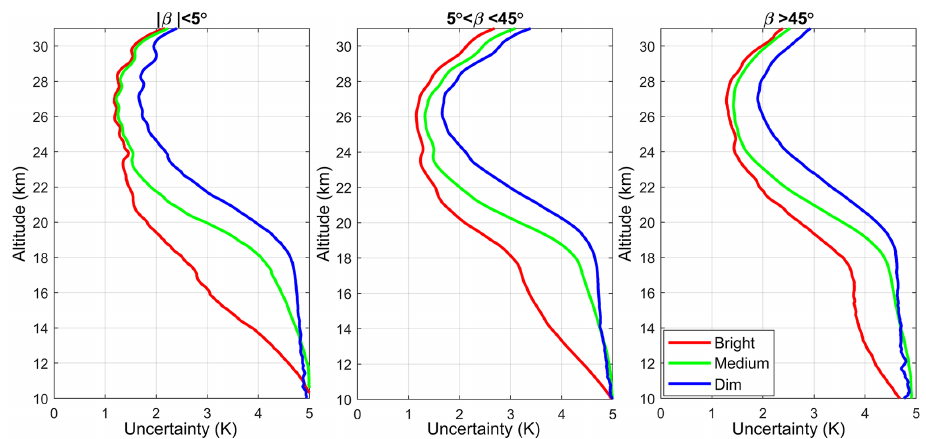
Figure 9. Mean uncertainties of HRTPs in the equatorial region (20 ◦ S–20 ◦ N) in 2004, for different obliquity angles β , specified in the panels, and for different stars: bright ( m < 1), medium (1 < m < 2 . 5) and dim ( m > 2 . 5).